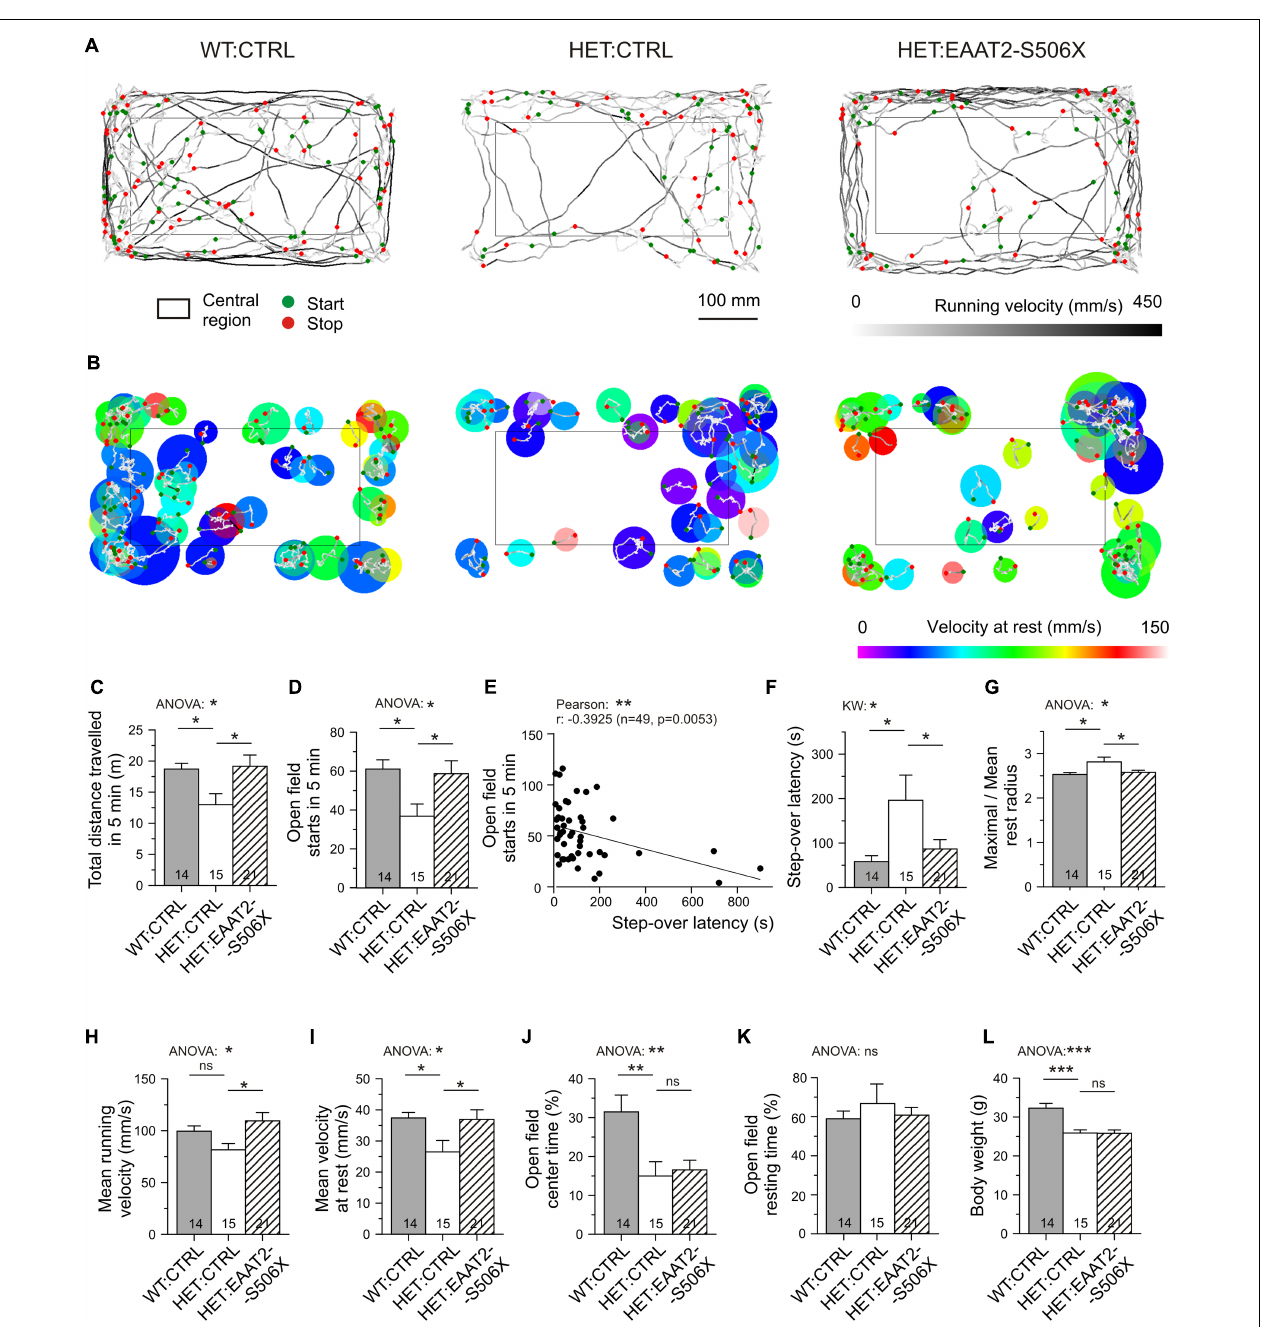
FIGURE 7 | Effects of bilateral EAAT2-S506X expression on the motor performance of Q175 mice. (A) Recordings of open field trajectories showing the mean running velocity between starts and stops (green or red circles, respectively). Gray level coding of instantaneous running velocity. (B) Motor activity at rest. Color coding of movement velocity at rest. (C,D,F–K) Quantification of results from open field testing. (E,F) Step-over latency – inverse relationship with number of starts in the open field, and sensitivity of step-over latency to mHTT and treatment. (L) Matched age-, CAG-, and body-weight composition of the test groups (only body weight illustrated). * p < 0.05, ** p < 0.01, *** p <